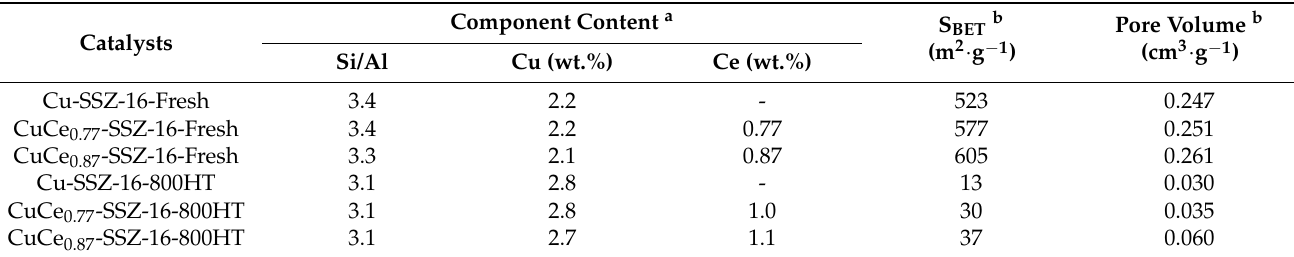
Table 1. The chemical compositions and textural parameters of Cu-SSZ-16-Fresh, CuCe 0.77 -SSZ-16-Fresh,